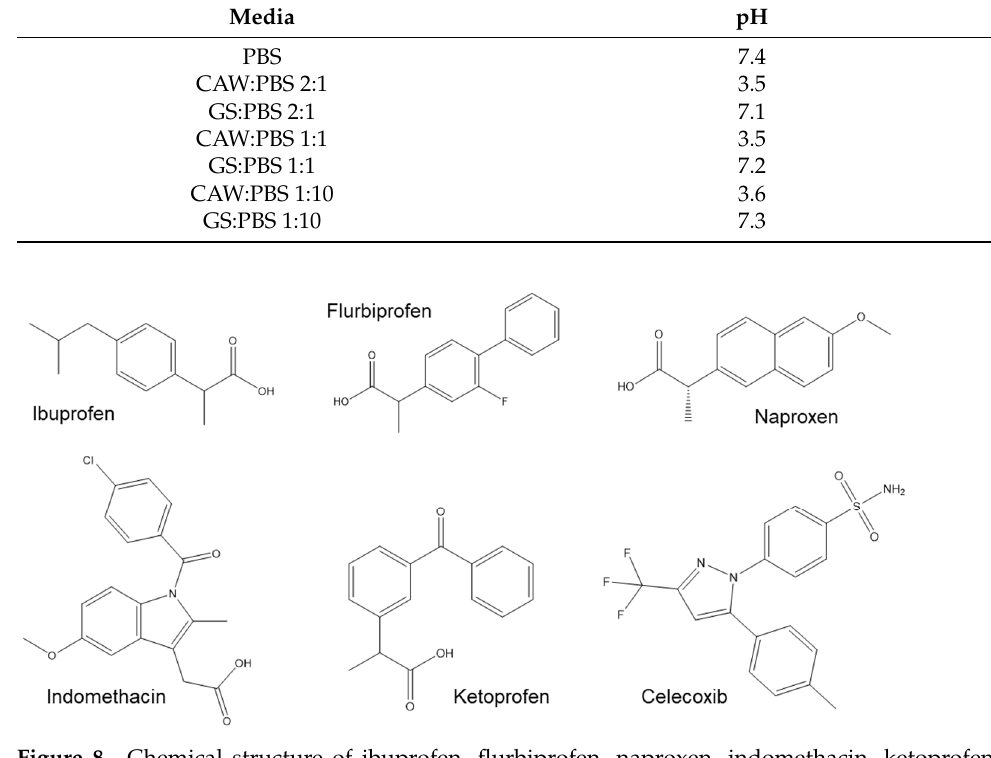
Figure 8. Chemical structure of ibuprofen, flurbiprofen, naproxen, indomethacin, ketoprofen, and celecoxib.